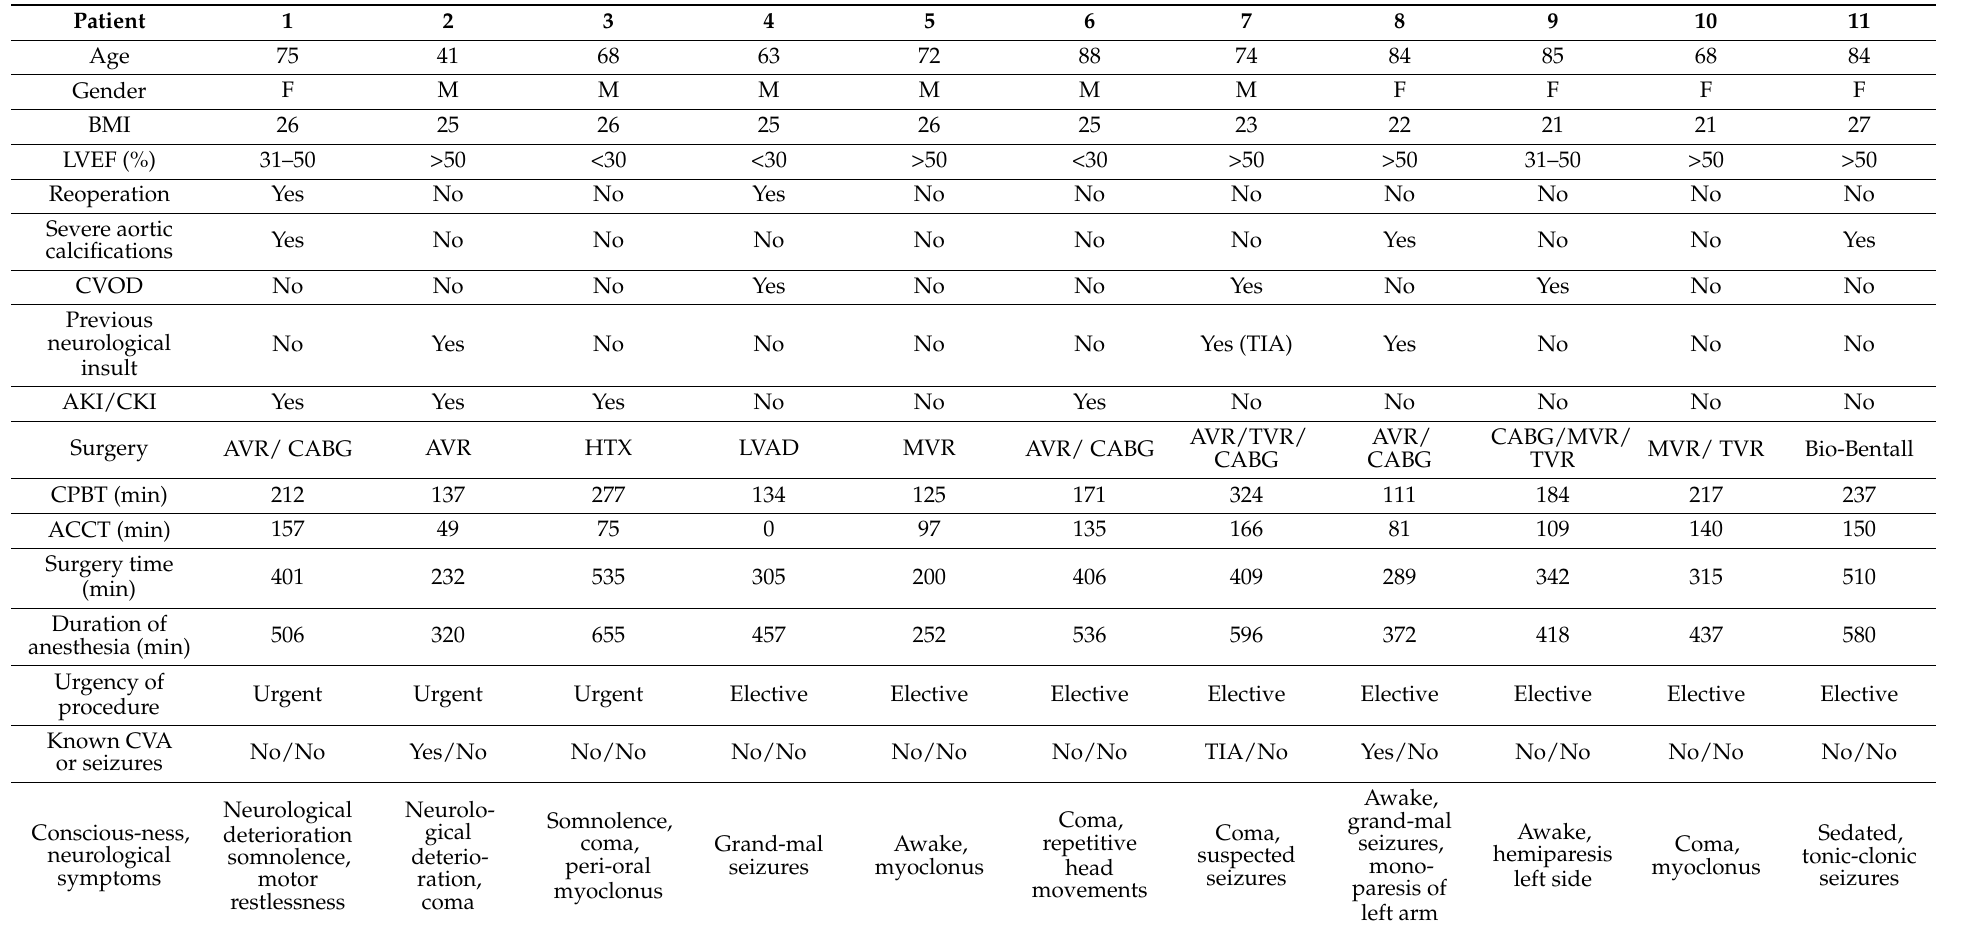
Table 2. Perioperative data from patients with confirmed de novo NCSE after cardiac surgery on cardiopulmonary